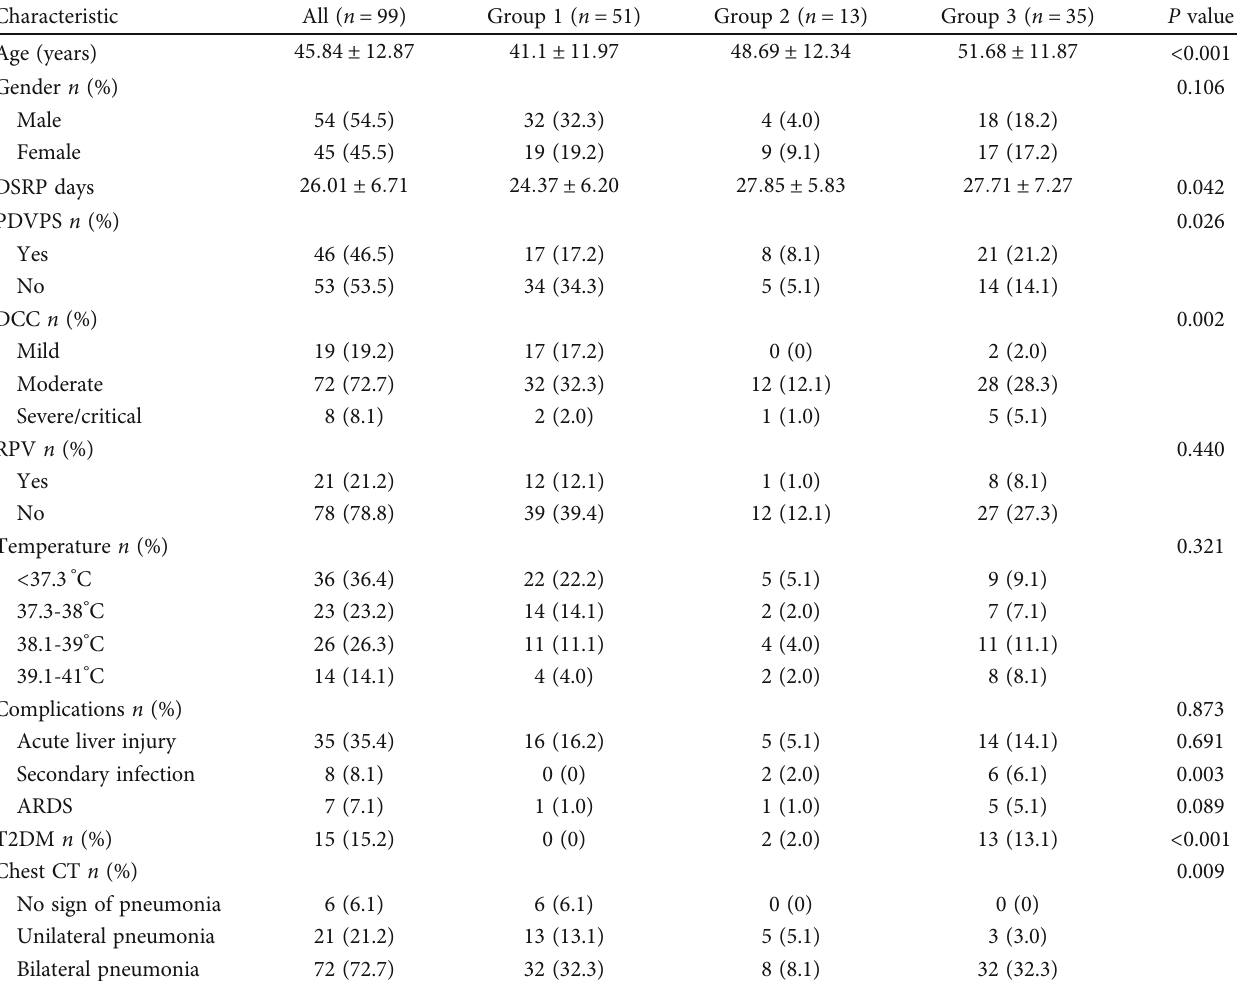
Table 1: Characteristics of COVID-19 patients at